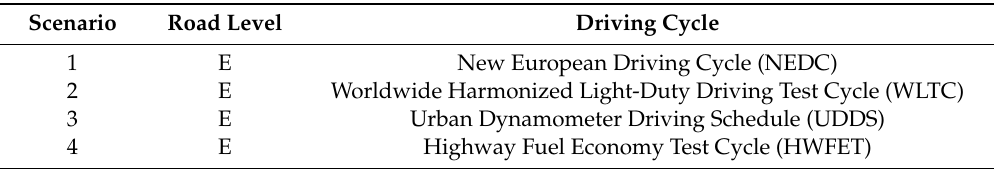
Table 4. Different combination scenarios of road levels and driving cycle inputs.